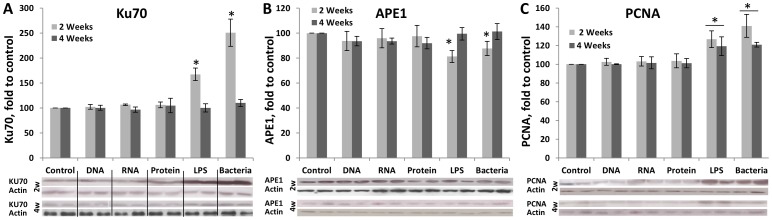
Western blot analysis of KU70 (A), APE1 (B) and PCNA (C) protein levels in liver tissue of mice exposed to whole heat-killed E. coli O157:H7 bacteria and DNA, RNA, protein, and LPS extracted from heat-killed bacteria.Bars show the average protein levels (with SD) as compared to the control set at 100%. Asterisks and bars show significant increase from non-exposed controls through the analysis of data using one way ANOVA test (p<0.05). Lower panel shows representative Western blots in 2 and 4 weeks groups.